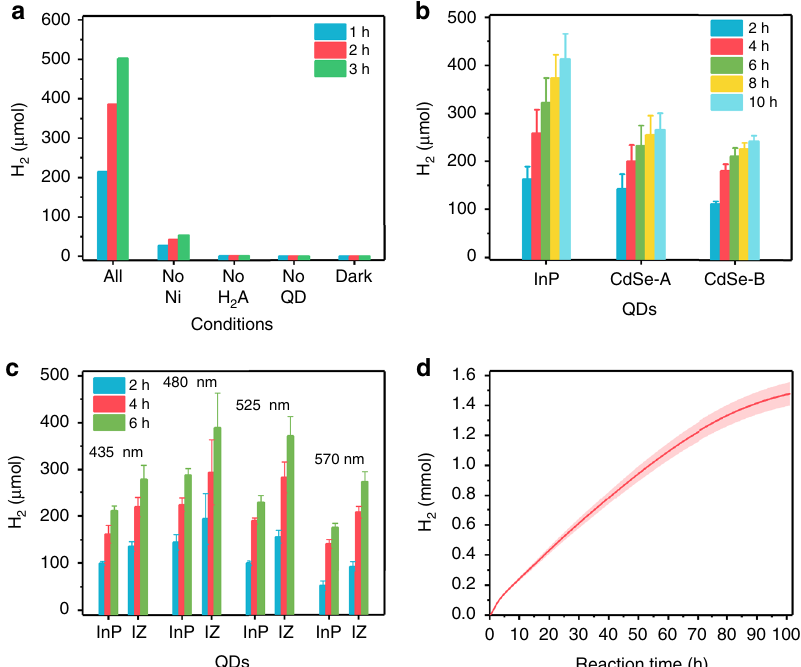
Fig. 2 Photocatalytic hydrogen evolution experiments. a Amount of hydrogen evolved from reference systems without Ni 2 + , H 2 A, QDs or light illumination, respectively. b Comparison of hydrogen evolution results with InP-S QDs (525 nm) and two types of CdSe-S QDs (~525nm). c Hydrogen evolution with InP-S QDs and InP/ZnS-S QDs (abbreviated as IZ) with different excitonic absorption peaks. d Long time hydrogen evolution of InP/ZnS-S QDs (shadowed area: error range). Conditions: a 1.6 μ M InP/ZnS QDs, b 1.6 μ M InP-S QDs (525 nm) and CdSe-S QDs with the same absorbance at 525 nm or c 2 μ mol (of molecular concentration) QDs with different absorption peak, with 0.035 mM Ni 2 + in 6 mL of 0.2 M H 2 A (pH 4.5) were illuminated with a , b LED light source (525 nm, 4 × 1 W) and c AM 1.5 simulator light; d 1.9 μ M QDs (525 nm, 15 min) and 0.042 mM Ni 2 + in 10 mL of 0.2 M H 2 A (pH 4.5) with LED light source (453 nm, 0.23 W). Error bars were estimated based on the standard deviation according to two or more independent